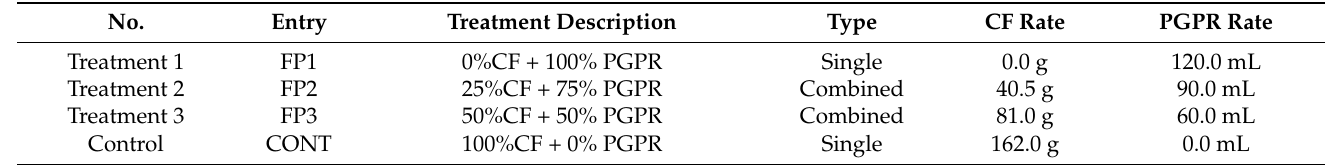
Table 2. Treatment description and rate of treatment application according to the plot size of 6 m 2